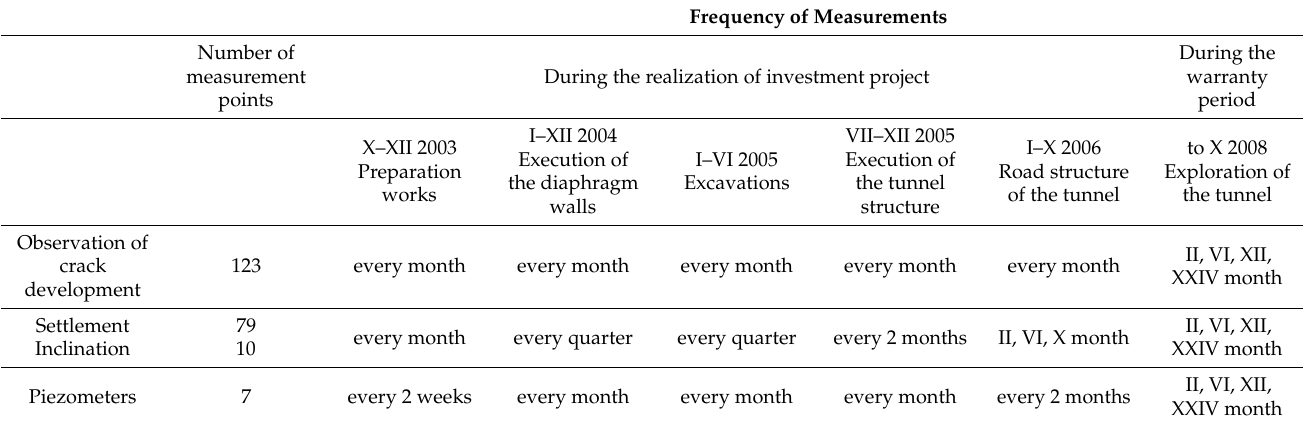
Table 1. Frequency of measurements as part of the monitoring involving the impact on the neighborhood of tunnel construction under the roundabout in